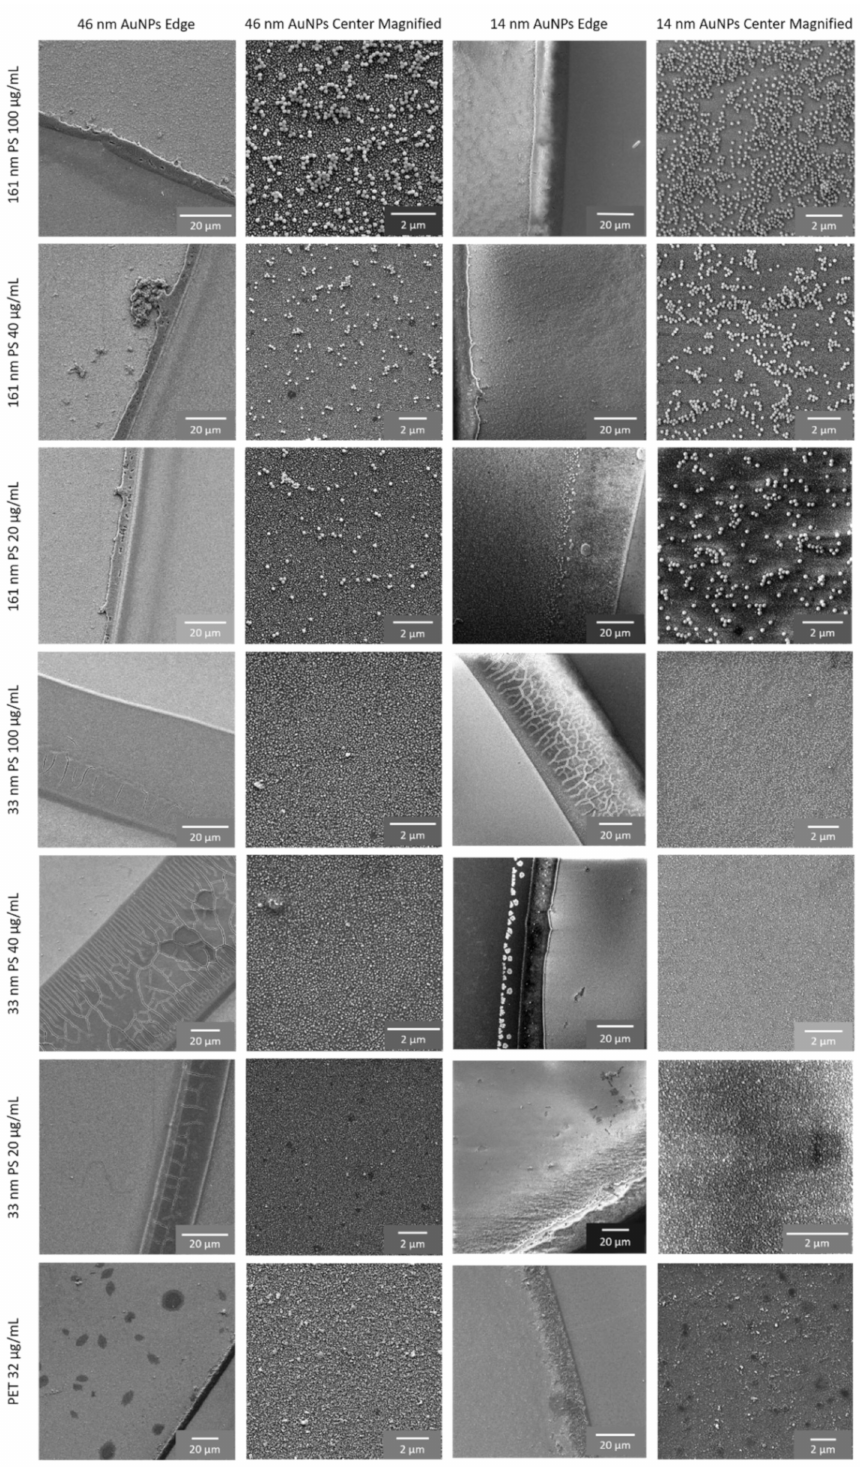
Figure A3. SEM images for the final, dried plastic particle samples on the SERS substrates. Image columns are labelled with the gold nanoparticle type used to create the substrate. Image rows are labelled with the type of plastic particle sample represented. 20 µ m scale images show the dried edge of the plastic samples. 2 µ m images are obtained from the sample